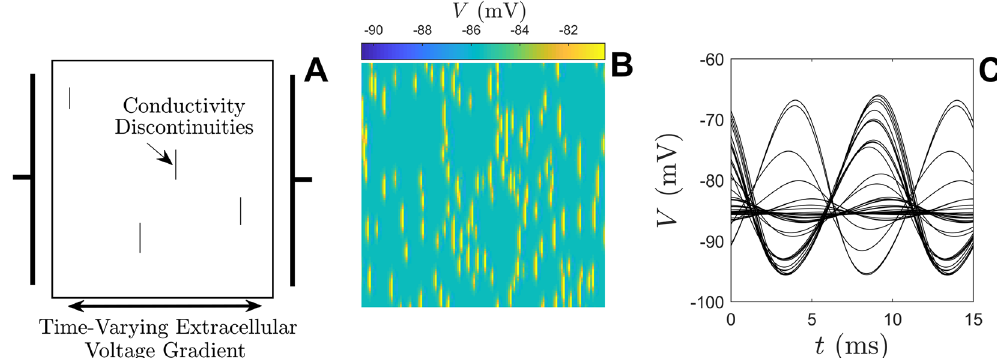
Figure 8. Panel A shows a schematic of the 2D bidomain model domain from (14). Black lines show a subset of the extracellular gap junctions that have been removed representing insulating plaque between myocardial fibers. The resulting interfaces between extracellular conductivities create virtual electrodes that act as activation sites when an extracellular voltage gradient is applied. Panel B gives a snapshot in time of the transmembrane voltage when a small amplitude alternating current is applied highlighting the locations of virtual electrodes. Figure C shows a representative set of voltage traces during the application of this alternating electric field. Cells that are closest to the virtual electrodes receive the largest influence from the extracellular voltage gradient. Cells that are far away from the virtual electrodes are not strongly